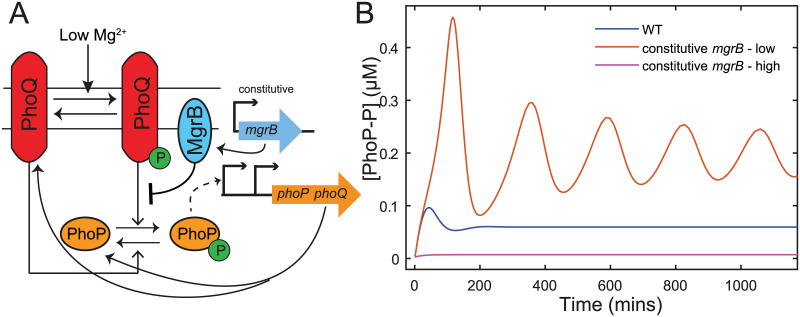
Removing upregulation of mgrB can result in oscillations in the two component system.A—Model schematic of an in silico mutant expressing mgrB constitutively instead of being expressed from the PhoP-P dependent promoter PmgrB B—Simulations of PhoP-P following a switch from high (50 mM) to intermediate (1 mM) Mg2+ show oscillations if mgrB is expressed at constant but low levels. Oscillations are absent in wild-type models, as well as models expressing mgrB at a constant high rate.